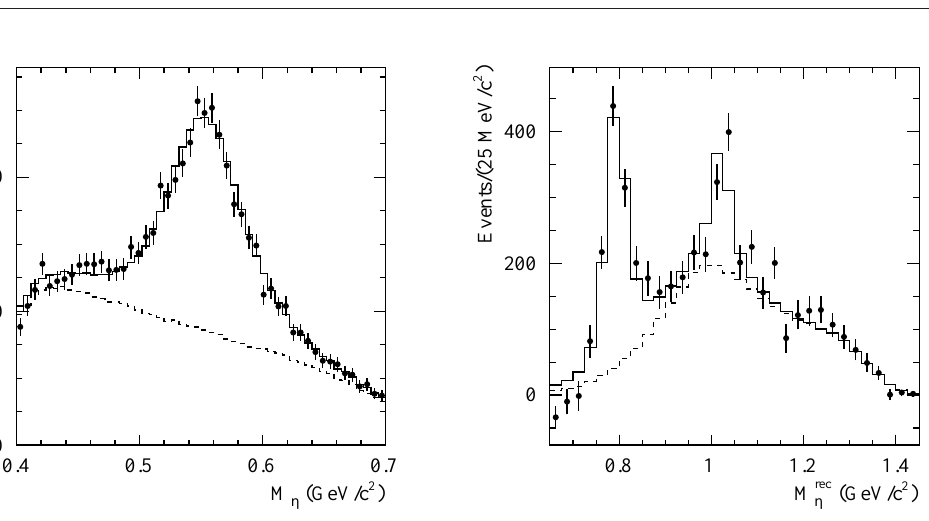
Figure 2. The M rec distribution for data e + e − → η π + π − π 0 η events (points with error bars). The solid histogram represents the result of the fit described in the text. The dashed histogram represents the sum of the e + e − → a 0 ρ and e + e − → nres